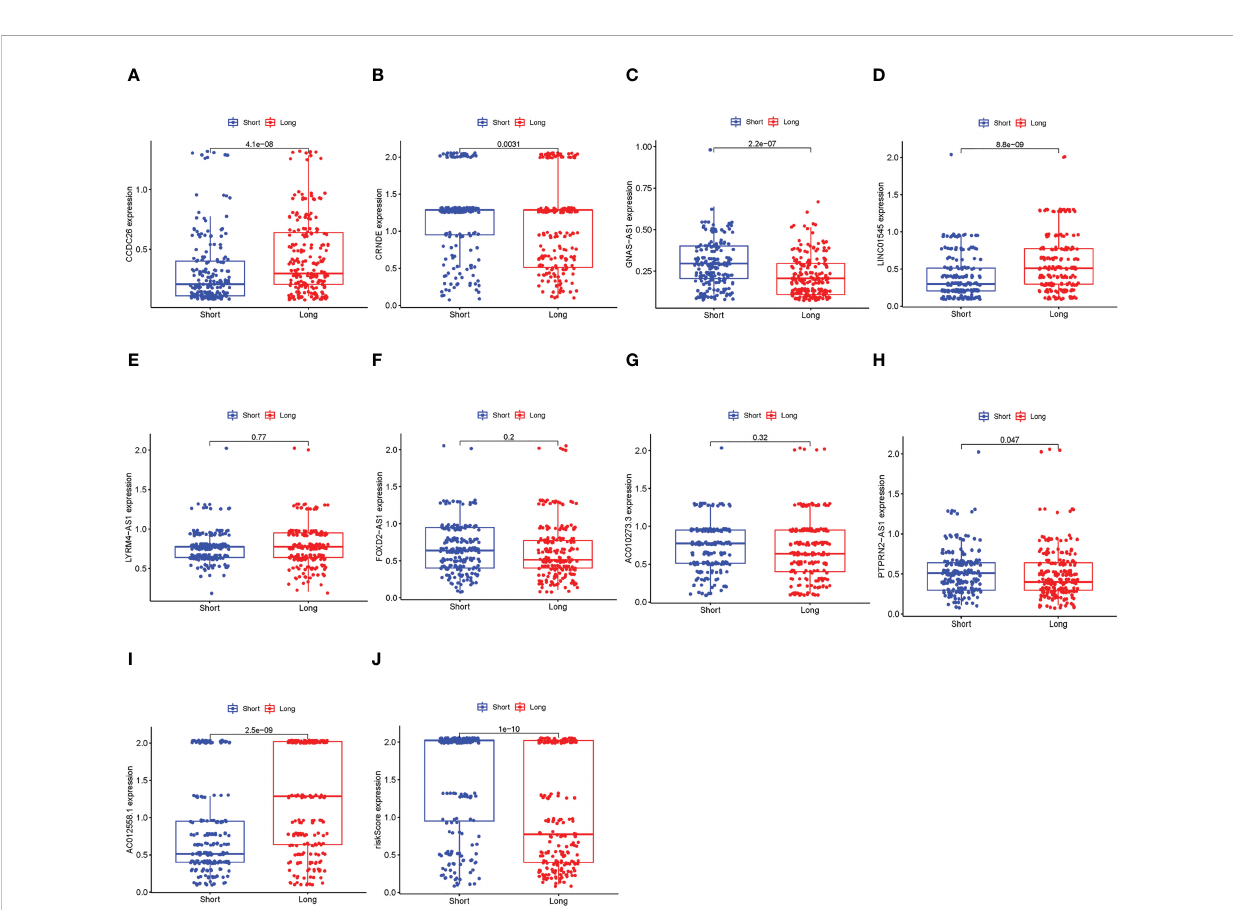
FIGURE 8 Comparison between the long-term survival and short-term survival groups. (A – I) The differential expression alnlysis between the long-term survival and the short-term survival groups of the 9 lncRNAs, p< 0.05 was considered statically siani fi cant. (J) The differential expression alnlysis between the long-term survival and the short-term survival groups of risk